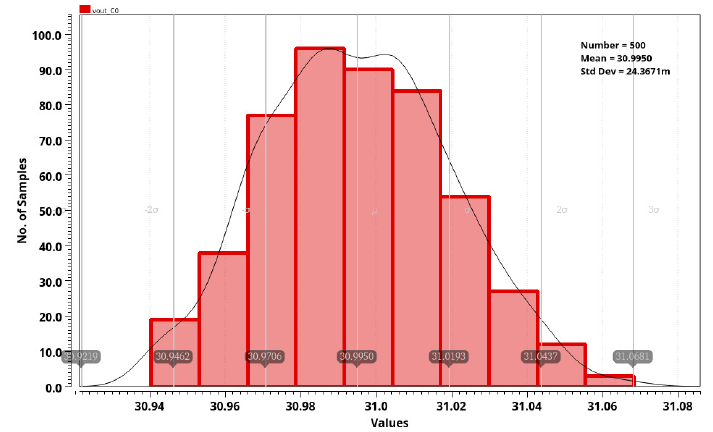
Figure 11. Monte Carlo simulation with A1A2 = 01, VBB = 24 V.